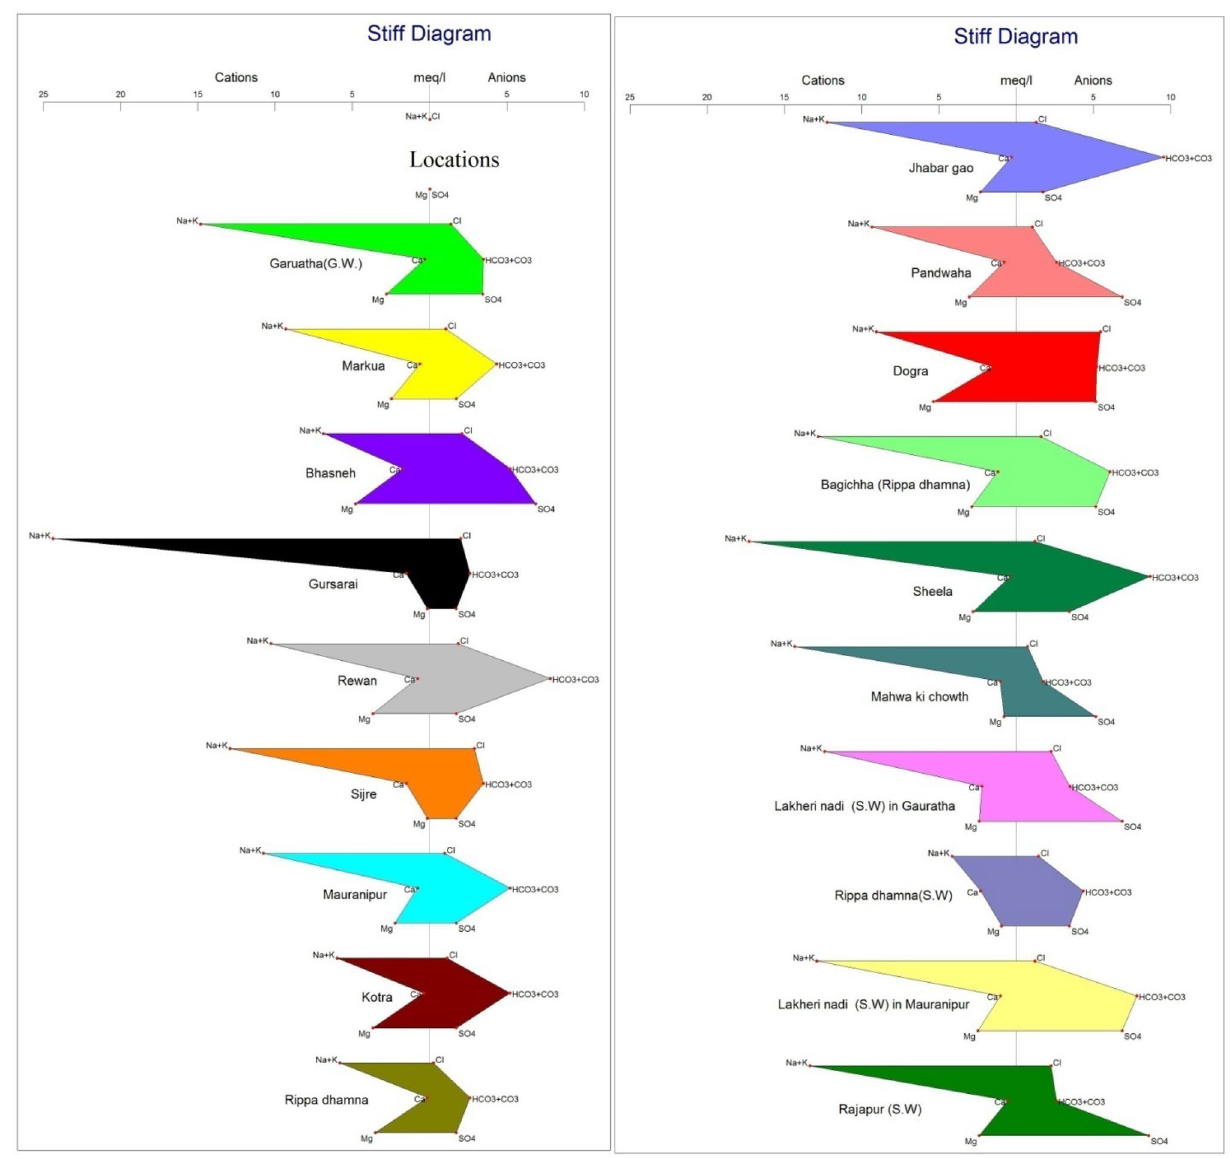
Fig. 9 Stiff diagram showing cation and anion concentration in all samples